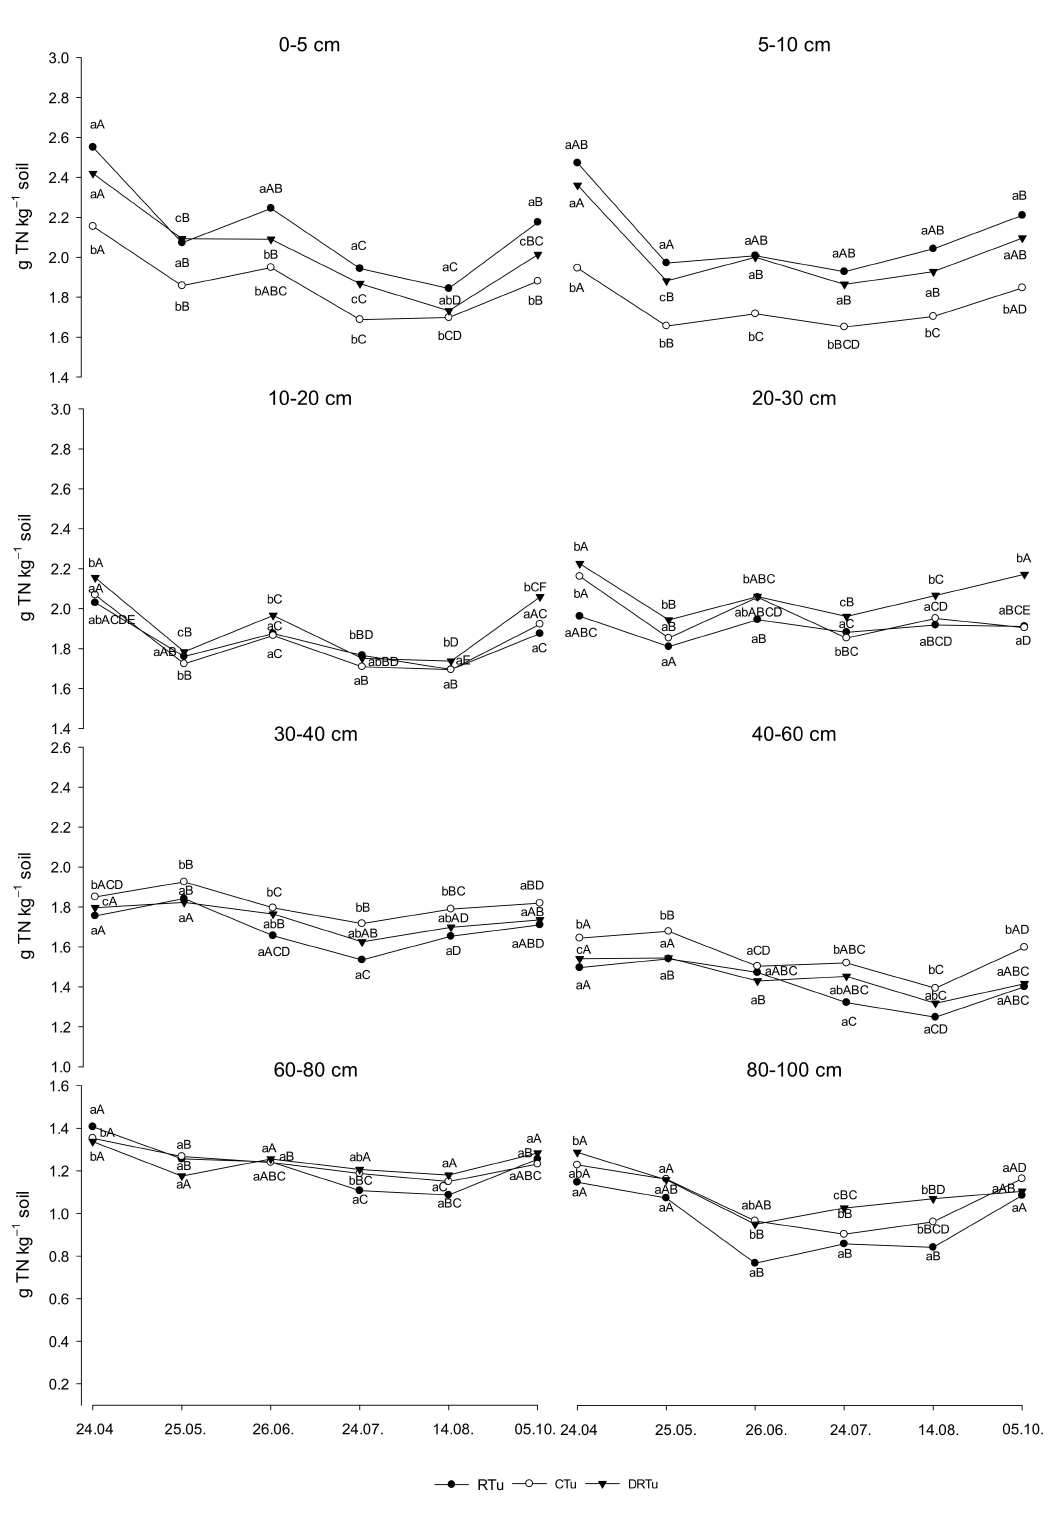
ranges across the growing season under 14 years of continuous application: reduced tillage (RTu), conventional tillage (Ctu) and deep reduced tillage (DRTu). The plant was—barley. Mean values by different lowercase letters demarcate a significant difference among different tillage adjustments within the same sampling time (significant differences a = 0.05). Mean values by different capital letters demarcate a significant difference among different sampling periods (significant differences a =